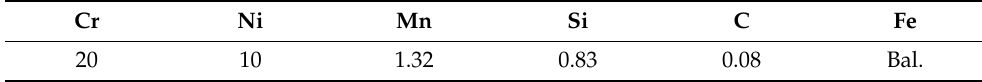
Table 1. Chemical composition of 304SS (weight fraction (%)).